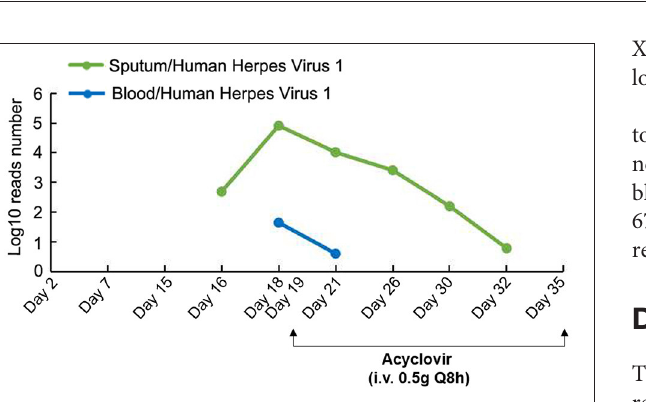
FIGURE 2 | Cycle threshold value of SARS-CoV-2. Blue: Nasopharyngeal swab. Red: Sputum.